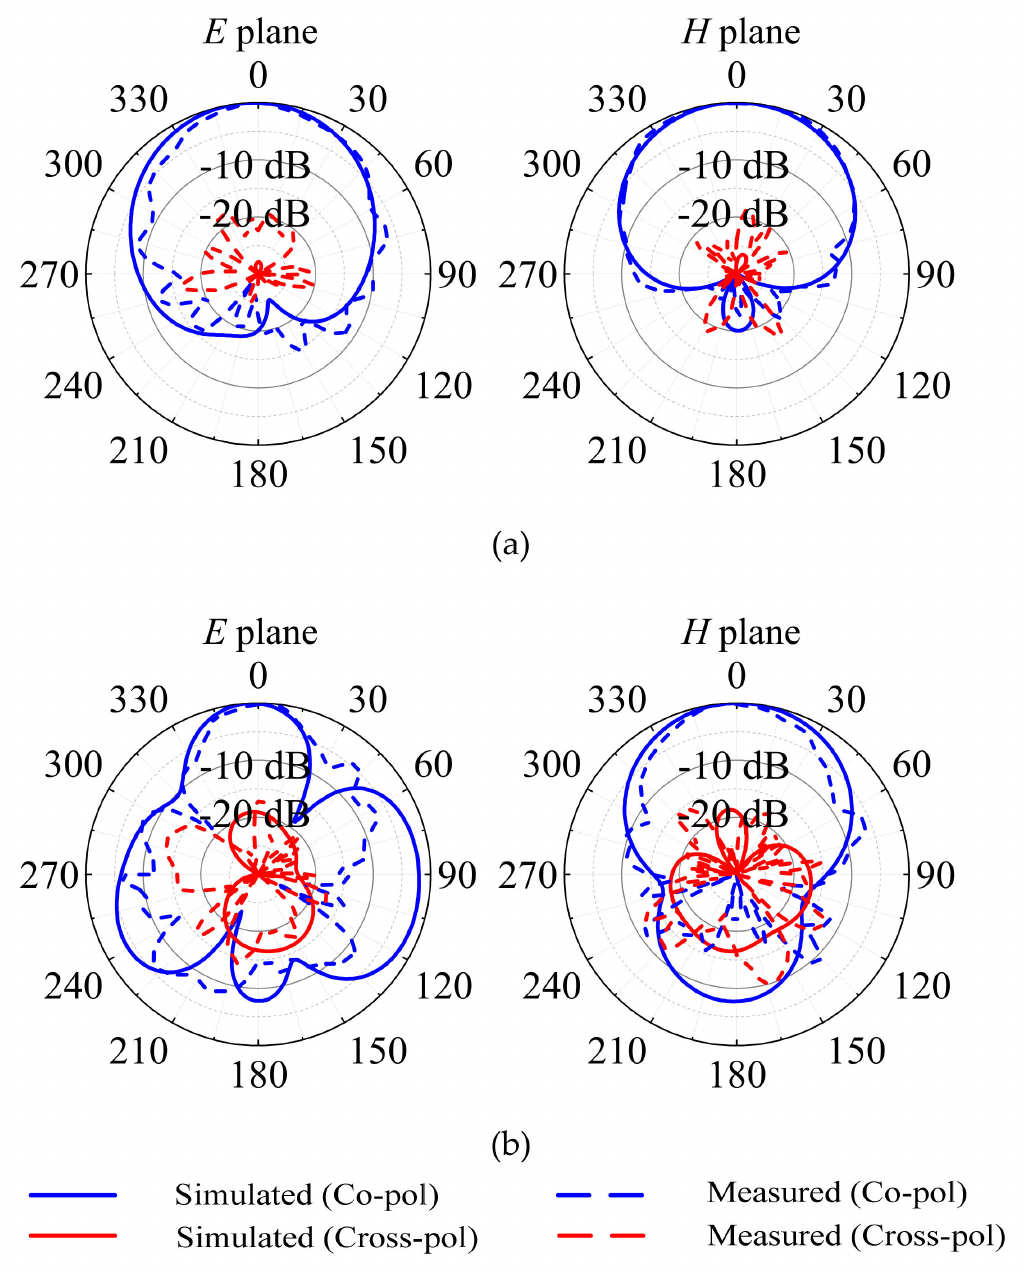
Figure 8. Simulated and measured radiation patterns of the proposed design at excitation port 2: ( a ) at 3.5 GHz; ( b ) at 4.9